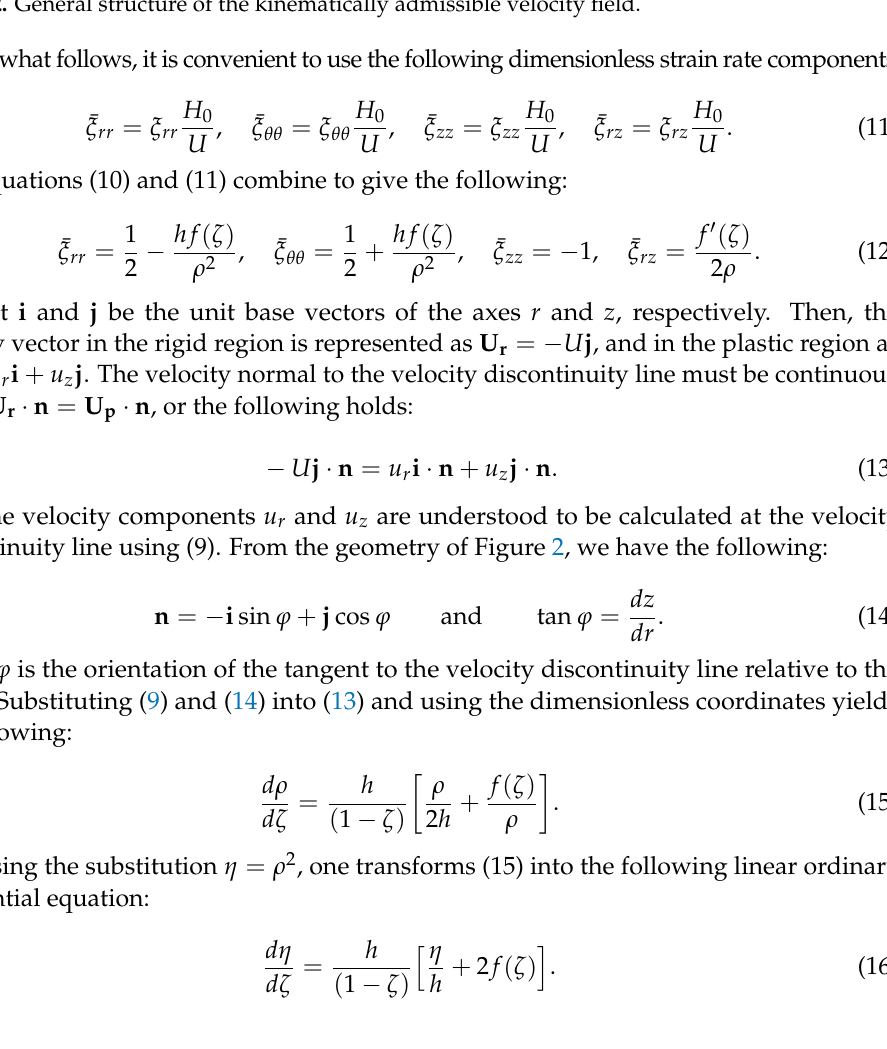
Figure 2. General structure of the kinematically admissible velocity